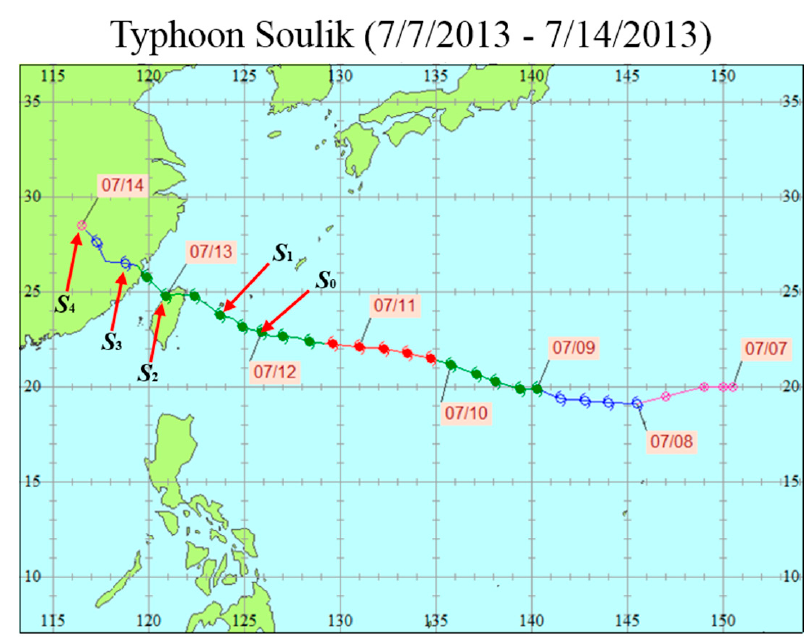
Figure 4. Track of typhoon Soulik from 7 to 14 June 2013, where symbol denotes the tropical depression with maximum wind speed Vmax < 17.2 m/s; the tropical storm, 17.2 m/s < Vmax < 32.6 m/s; the moderate typhoon, 32.7 m/s < Vmax < 50.9 m/s; a severe typhoon, 51 m/s < Vmax, and S 0 – S 4 are the five time instances with a 12 h of increment to show the flow fields, see Figure 6, for example, S 0 represents 00:00 of 12 July, S 1 12:00 of 12 July, S 2 00:00 of 13 July, S 3 12:00 of 13 July and S 4 00:00 of 14 July, 2013, respectively. (Modified from CWB of Taiwan).